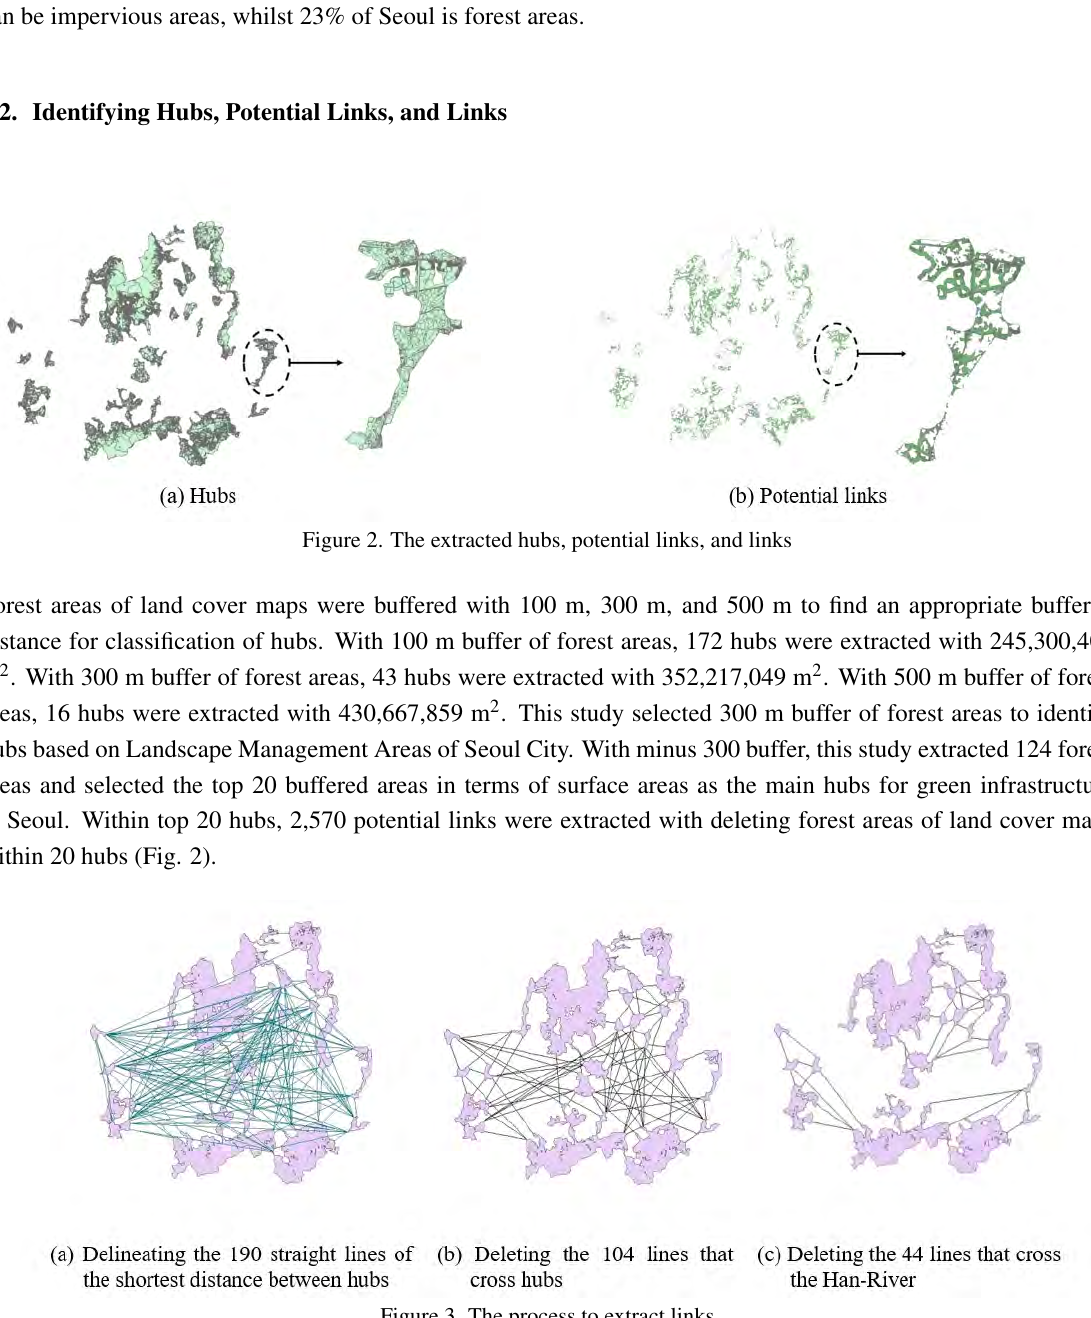
Figure 3. The process to extract